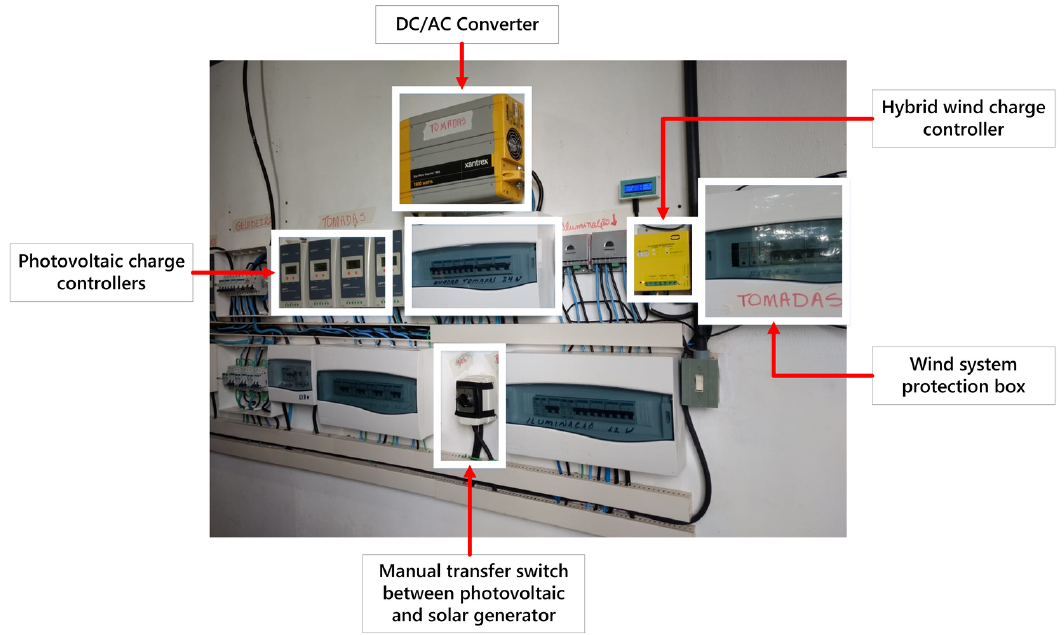
Figure 8. Components of the power conditioning